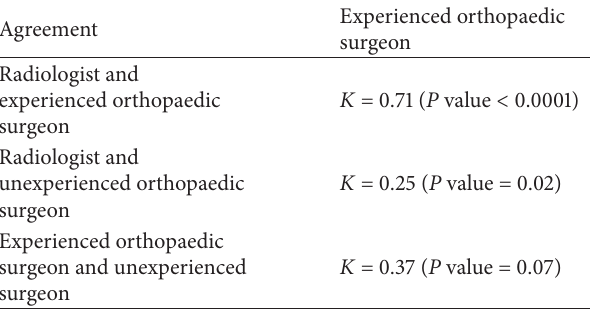
Table 4: Interobserver agreement observers with MRI